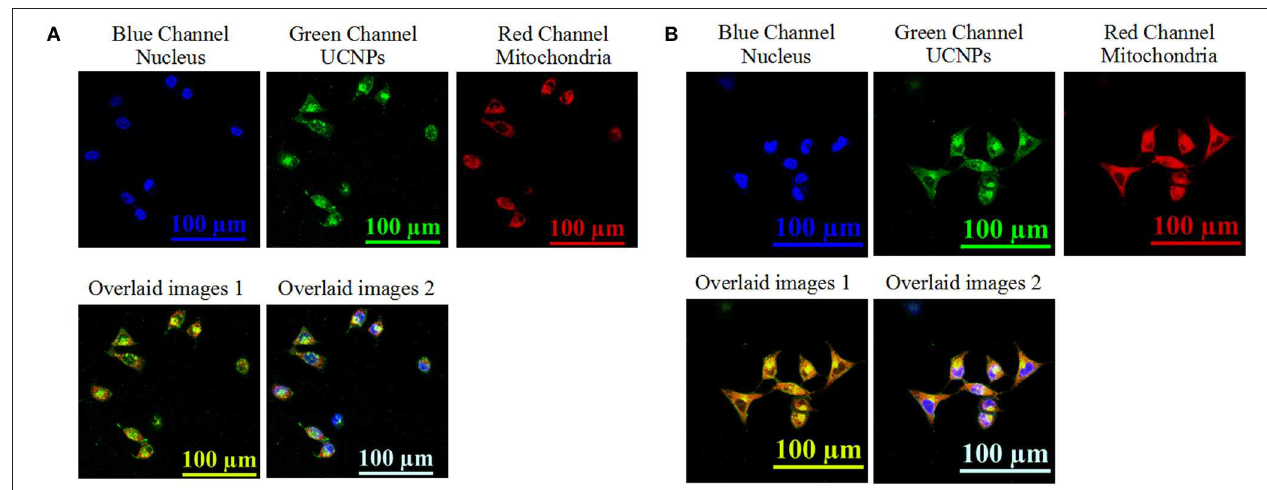
FIGURE 5 | Upconversion luminescence imaging of MCF-7 cells treated with 70 µ g/mL of (A) the prepared UCNPs@SiO 2 /HA/MB/ICG, (B) UCNPs@SiO 2 /HA/MB/ICG@PEG-TPP. The nucleus information was collected at the blue channel from 420nm to 480nm under the excitation of 405nm laser; the UCNPs information was collected at the green channel from 515 to 575nm under the excitation of NIR laser; the mitochondria information was collected at the red channel form 650 to 720nm under the excitation of 633nm; overlaid image 1 consisted of the green channel and red channel; overlaid image 2 consisted of the blue channel, green channel, and red channel.